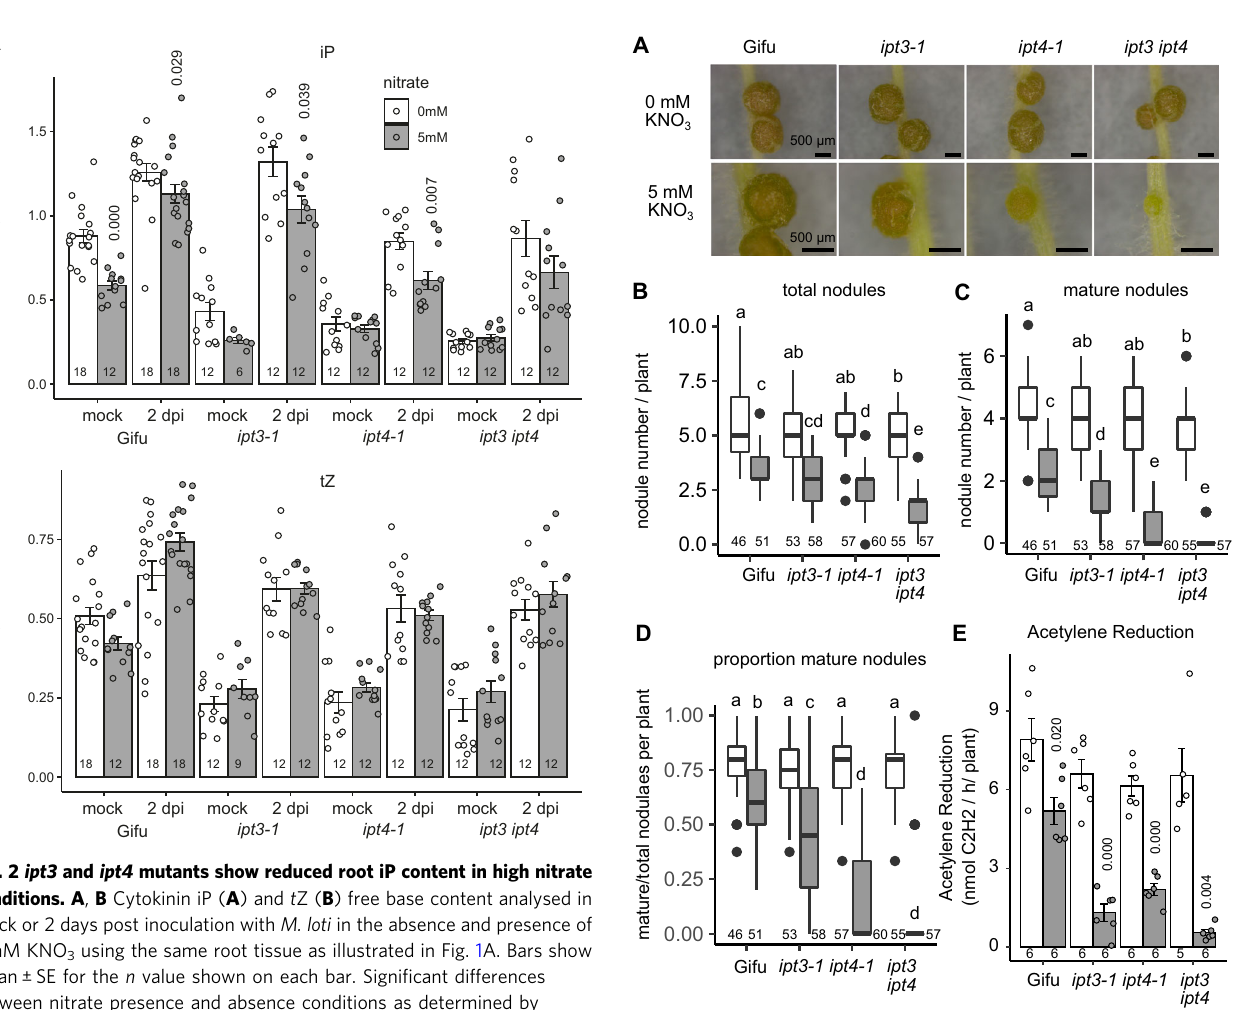
elongation is also seen in ipt3-2 ipt4-1 grown on 10 -8 M BA (Supplementary Fig. 2). However, grown in the presence of BA (10 -8 M BA), ipt3-2 ipt4-1 increases to an average of 0.90 mature pink nodules under the high nitrate condition, which is sig- ni fi cantly greater than the average 0.13 observed without added cytokinin (Fig. 5A – D). Applying BA at lower concentration (10 -9 M BA) is also able to trigger formation of more total nodules on ipt3-2 ipt4-1 in the presence of nitrate, while 10 -8 M BA did not increase total nodule numbers (Fig. 5B). In wild type,